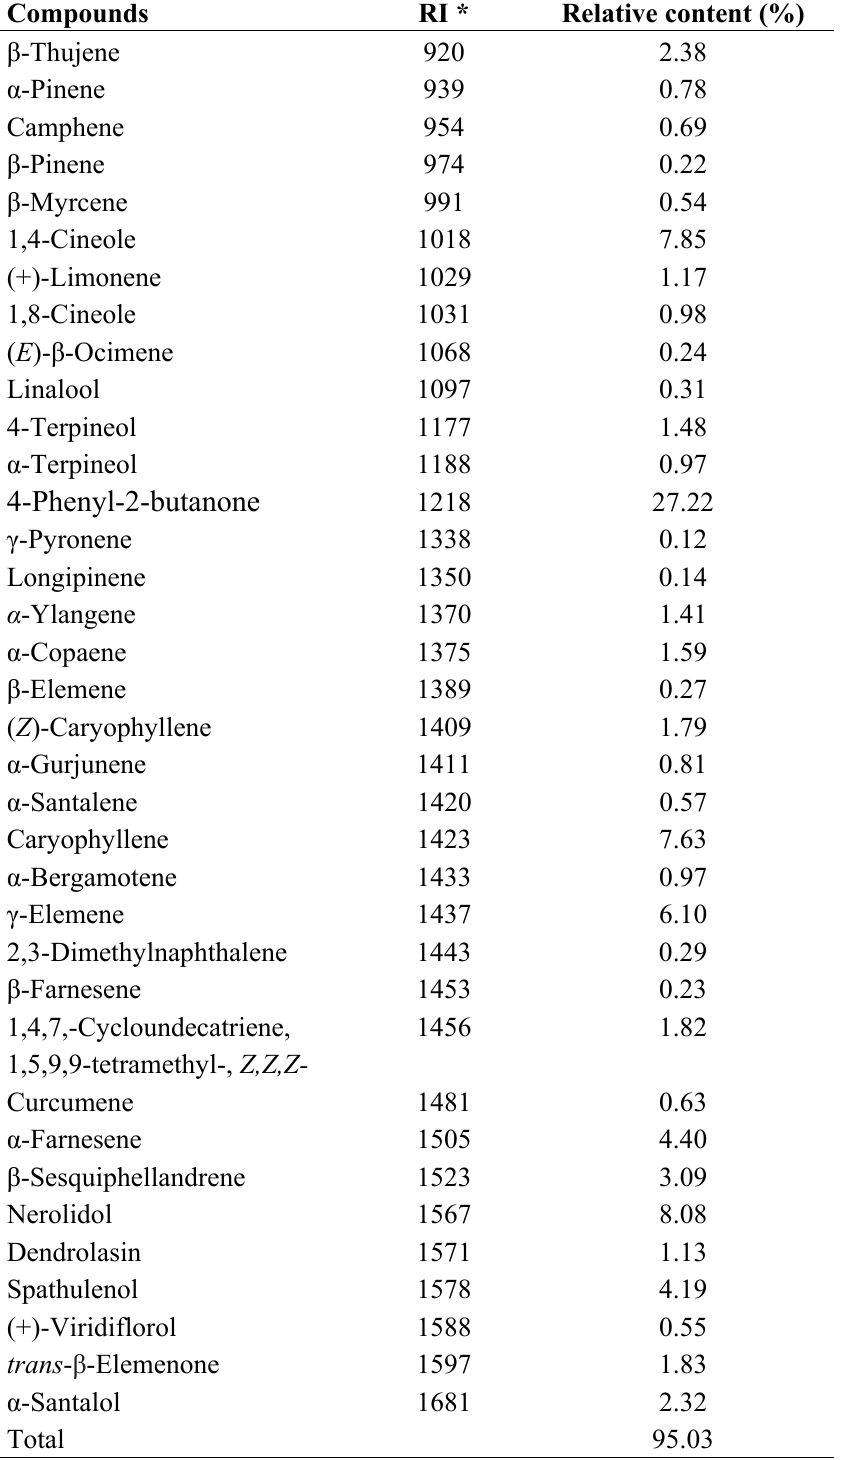
Table 1. Chemical composition of the essential oil of R. anthopogonoides flowering aerial